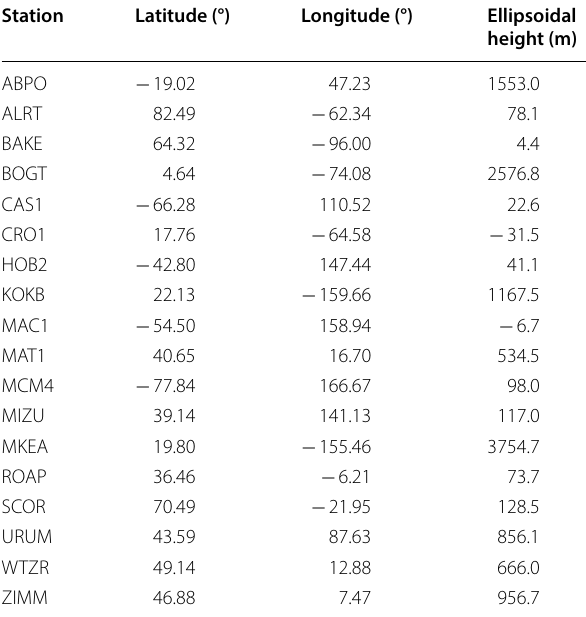
Table 1 Geodetic coordinates of the GPS stations used in the position domain